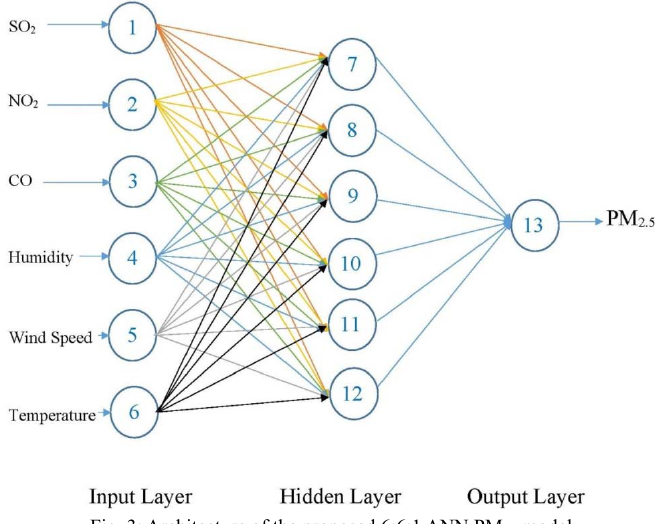
Fig. 3: Architecture of the proposed 6:6:1 ANN PM